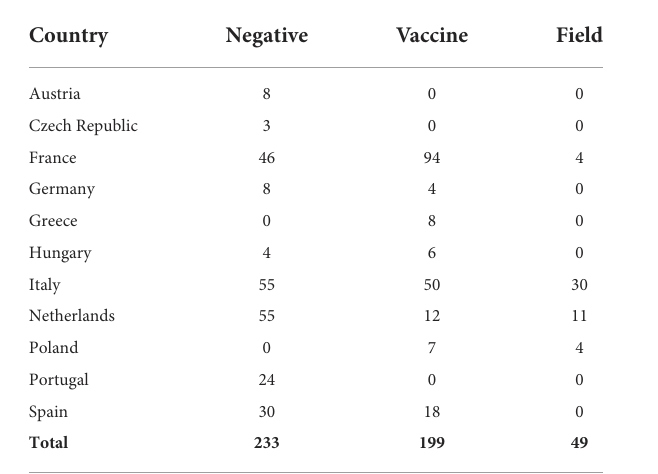
TABLE 1 Count of samples tested for each country classified according to the results of the diagnostic test and strain characterization.